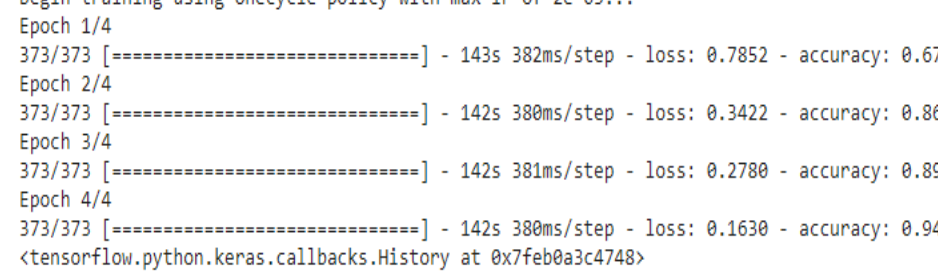
Figure 4. Model confusion matrix of our proposed CovBERT model. The error related to the training set (training loss) of the proposed dataset is shown in Figure 5. The training loss value starts with 0.8. Then, it gradually falls until 0.2 in the third epoch. Figure 6 shows the accuracy evolution over time. We noticed that the accu- racy increases over time from 84% in epoch 1 to 94% in epoch 4. We concluded that, from one epoch to another, the model acquired more knowledge and proved its effectiveness. Figure 5. Training loss of our proposed CovBERT model.